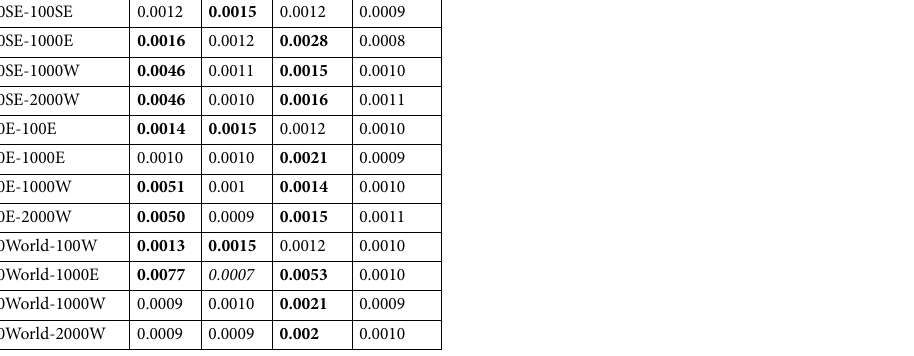
Table 3. Type I error rates of the different approaches for the small sample scenarios. The nominal level alpha considered is α = 0.001 . Type I error rates under the lower bound of the 95%PI are displayed in italic and above the upper bound of the 95%PI in bold. Supplementary Table S3 provides the adjusted 95%PI for the different number of genes tested in each